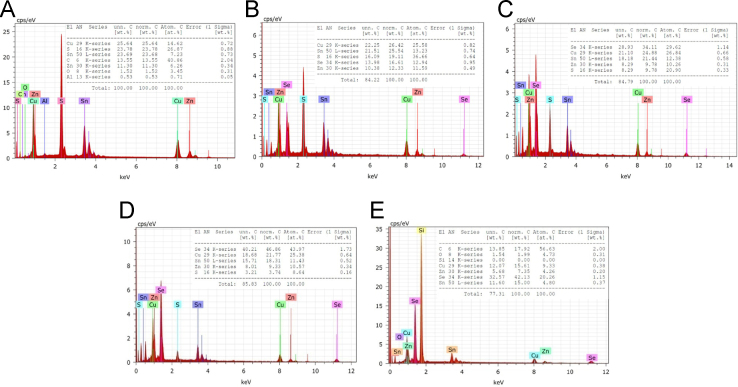
(A–E) EDAX Spectra recorded on CZTSxSe1−xnanocrystals for x=0–1. (A) x=1, (B) x=0.74, (C) x=0.42, (D) x=0.17 and (E) x=0. The inset shows the elemental distribution table obtained from EDAX.